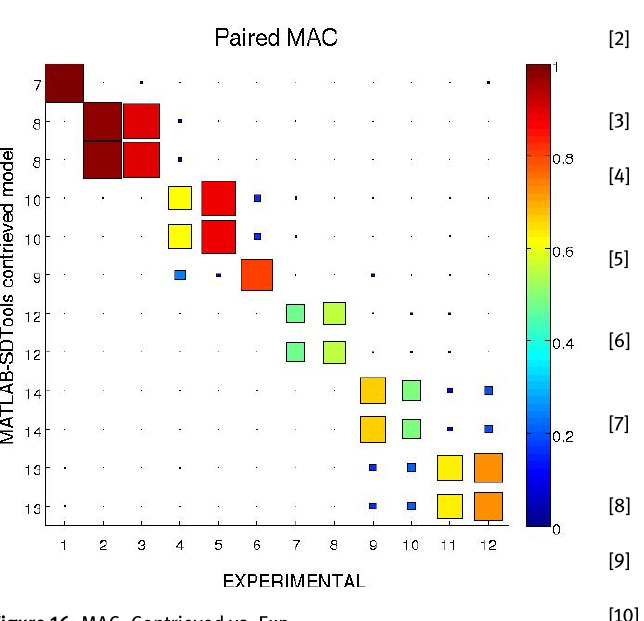
Figure 16: MAC: Contrieved vs.